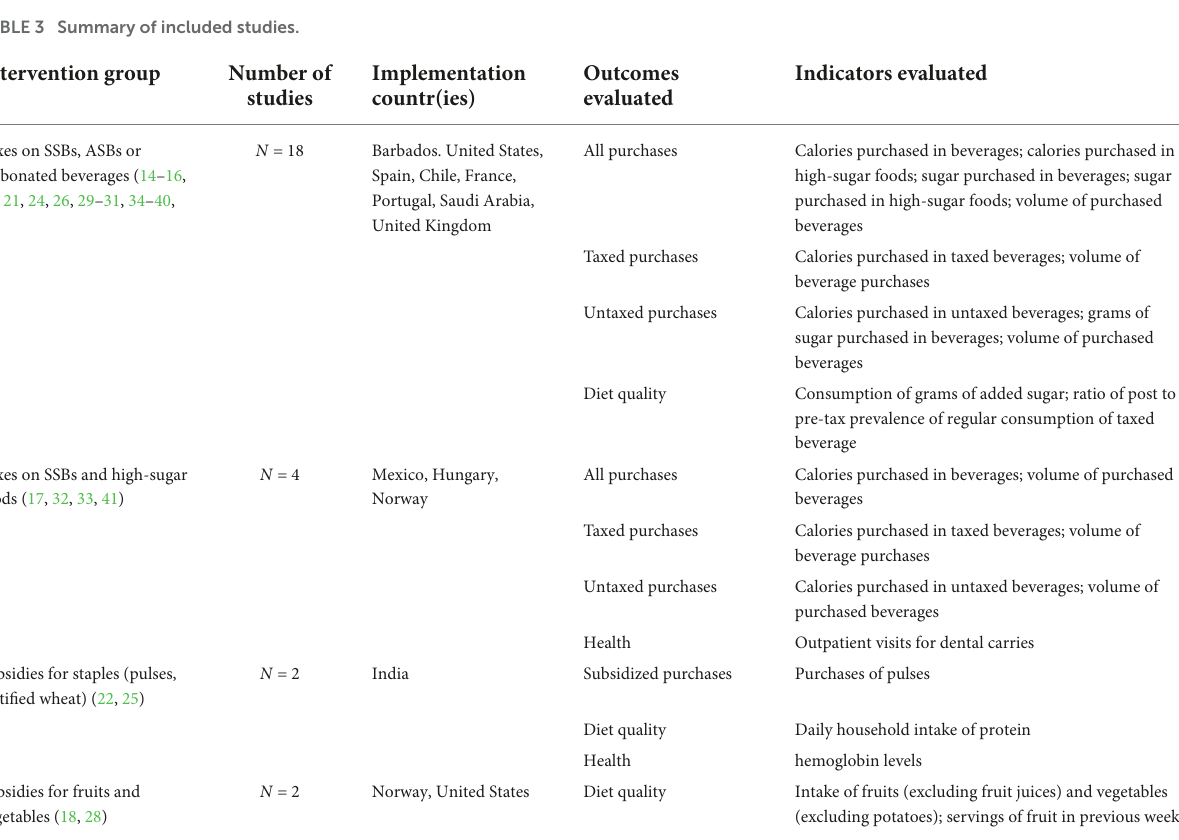
FIGURE3 Map of analyzed studies, 3ie (2022).